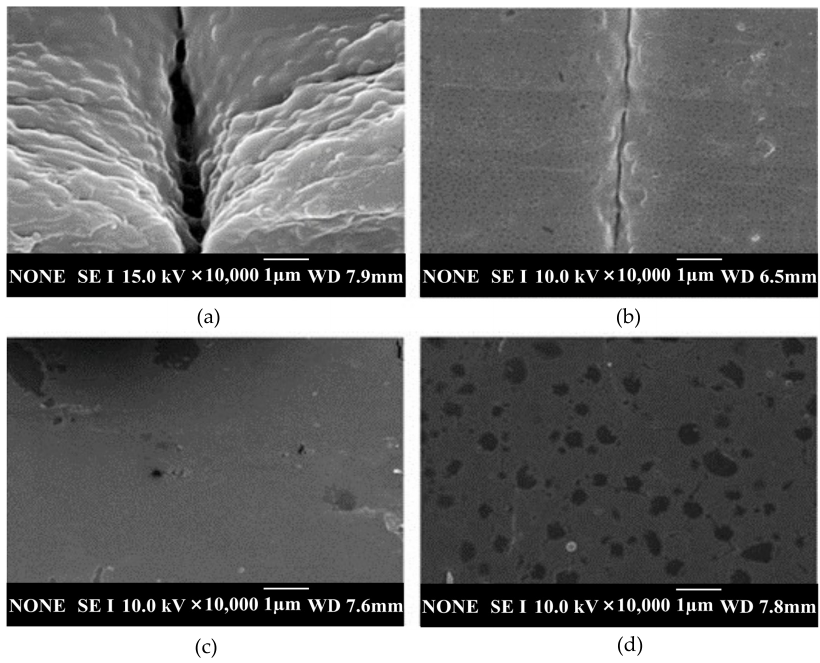
Figure 10. SEM images of one gate and two opposite gates: ( a ) two opposite gates at the temperature of 75 °C at point O without vapor chamber system; ( b ) two opposite gates at the temperature of 75 °C at point O with vapor chamber system; ( c ) two opposite gates at the temperature of 110 °C at point O with vapor chamber system; ( d ) one gate at the temperature of 75 °C at point O without vapor chamber system [46].